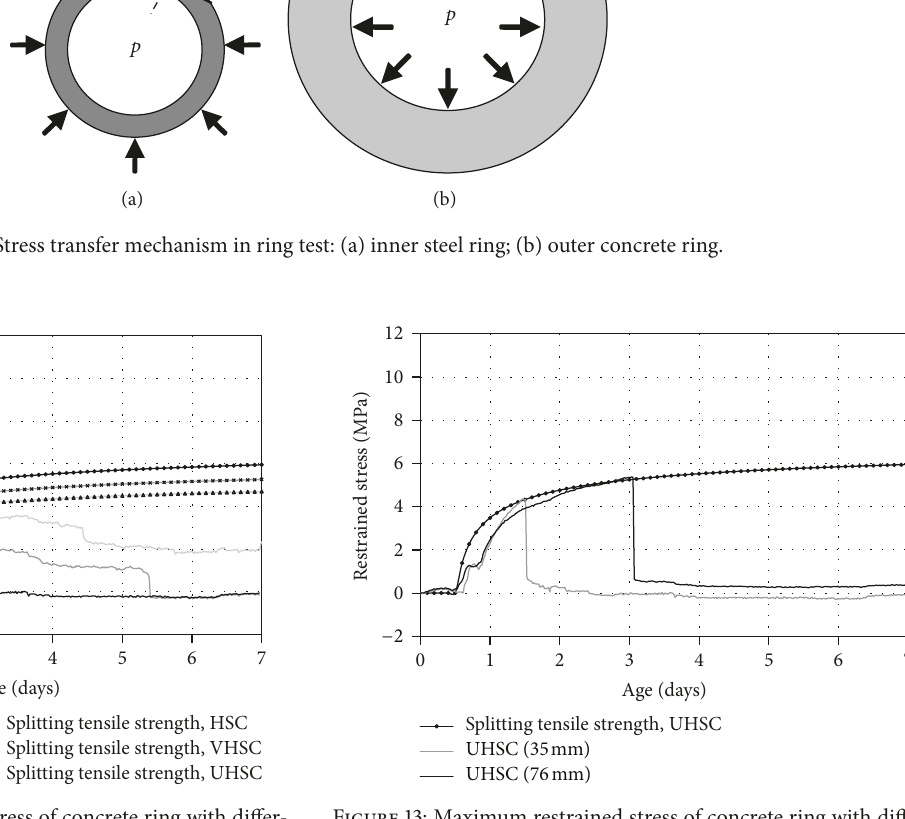
Figure 12: Maximum restrained stress of concrete ring with differ- ent strength levels.